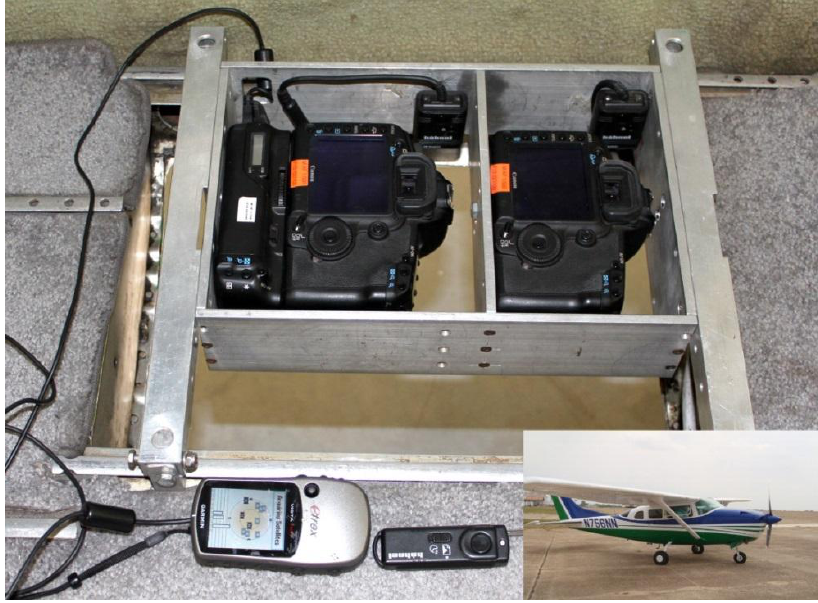
Figure 2. A two-camera imaging system installed over a camera port in a Cessna 206